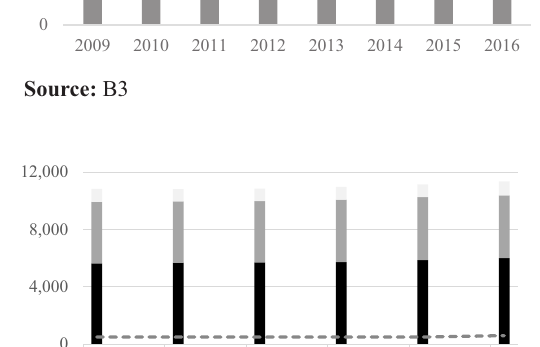
Figure 1. Number of